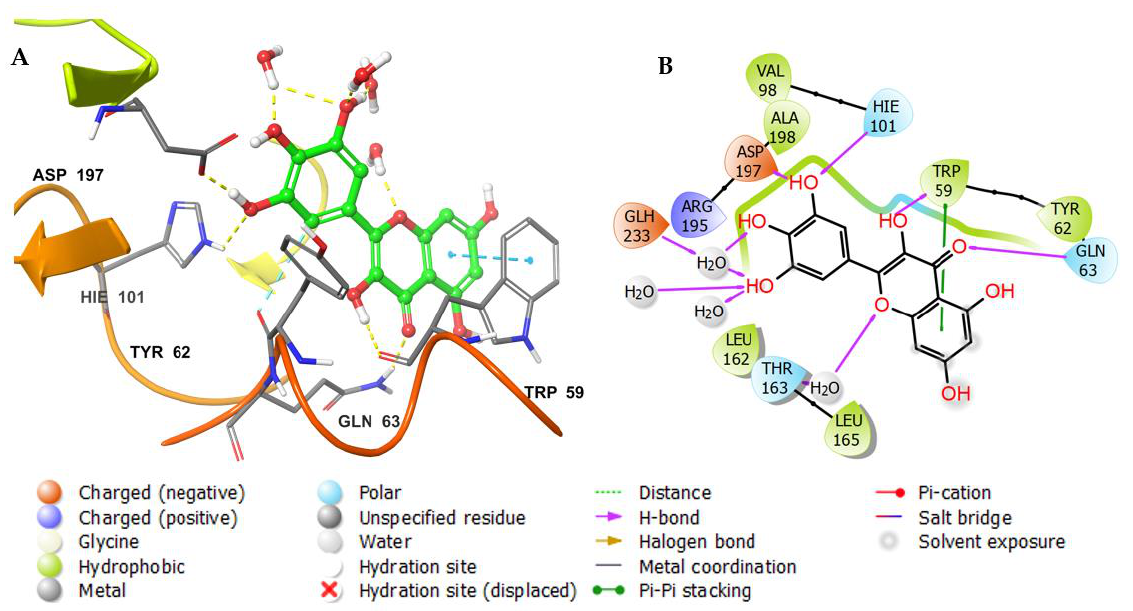
Figure 5. ( A ) Putative binding mode of the native inhibitor (myricetin) in the binding site of alpha-amylase (PDB: 4GQR). The native inhibitor is displayed as green sticks. The amino acid residues of the binding site are represented as thin tubes with color elements; pi-pi stacking and H-bonds are represented in cyan and yellow dotted lines, respectively. ( B ) 2D depiction of the ligand – protein interactions.